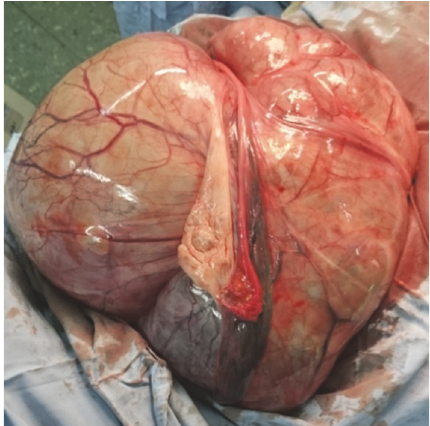
Figure 2: Gross appearance of tumor.